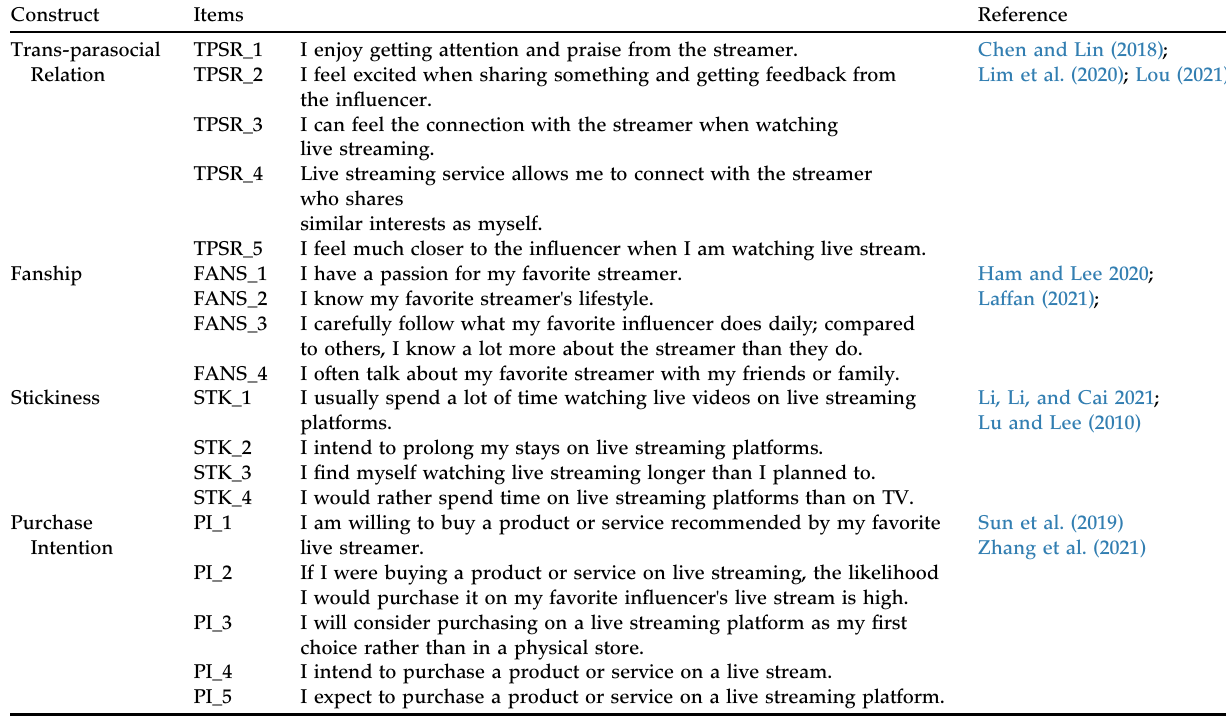
Table 1. Measurement items of key